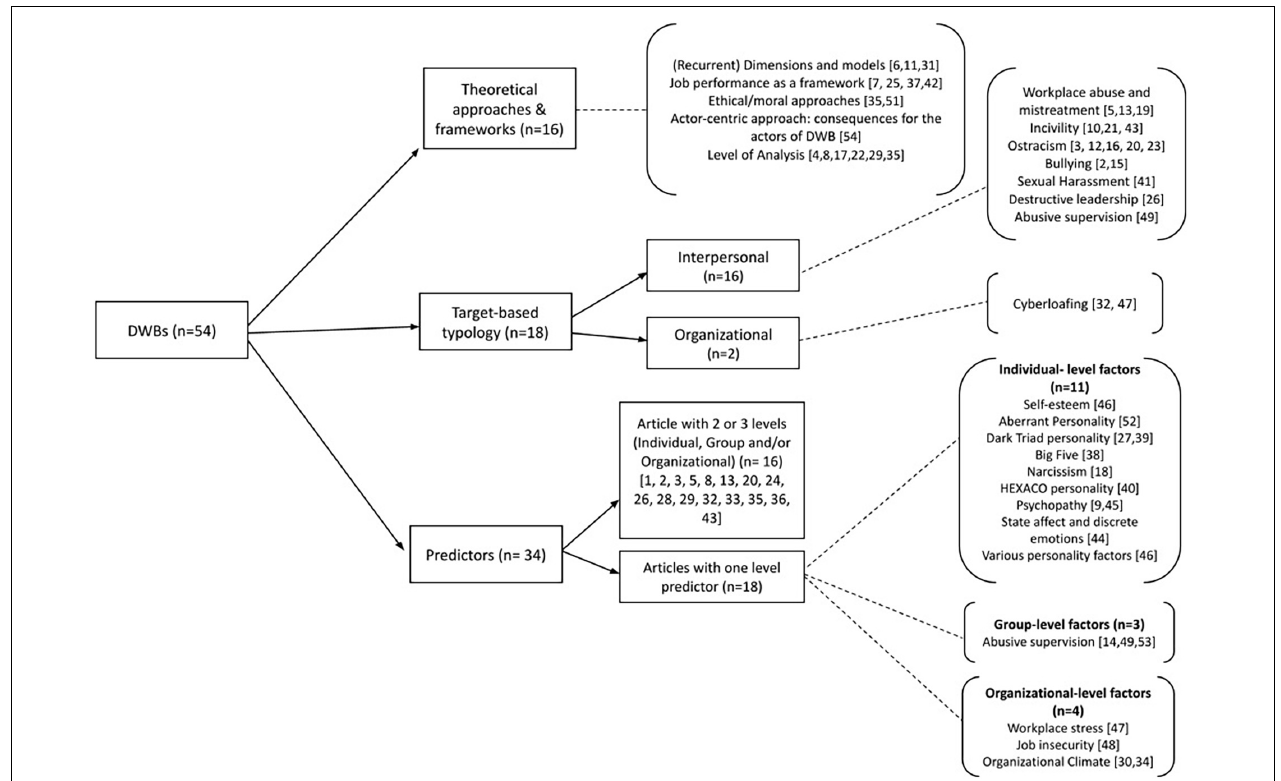
FIGURE 2 | Retrieved articles clustered and mapped on the basis of topic. [ Note: Numbers represent article codes reported in Table 1 ; the three categories (Approaches, Typology, and Predictors) are not mutually exclusive; for this reason total is greater than 54